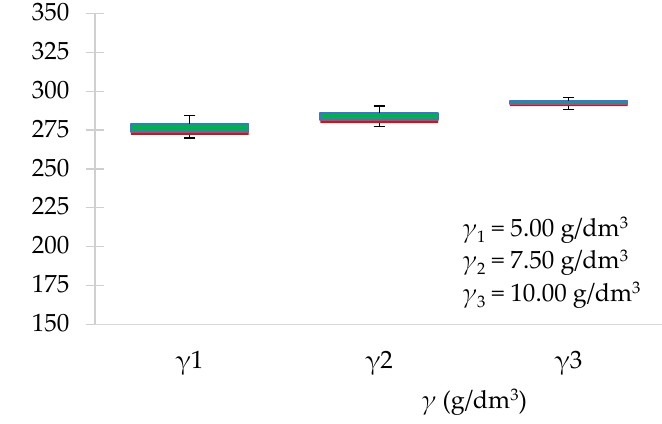
Figure 2. Dependence of N JS on the mass concentration of the zeolite suspension.